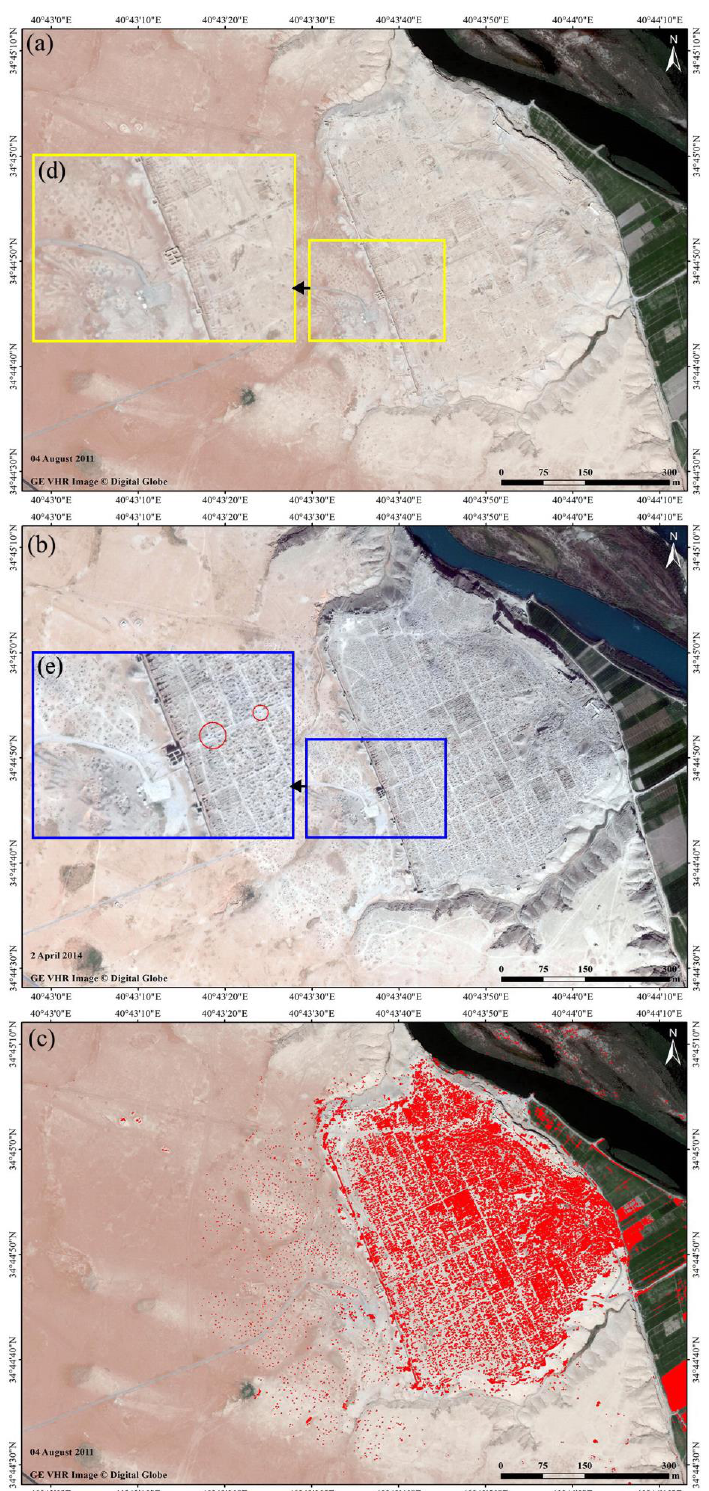
Figure 9. Dura Europos, eastern Syria, as it appears in images from August 2011 and April 2014. ( a ) Dozens of decades-old looting holes are visible in a close-up around the Palmyrene Gate; ( b ) The image from April 2014 shows a renewed phase of severe, war-related looting with fresh pits clearly visible in the same area; ( c ) The GE VHR image from 2011 was displayed with detected looting changes in red; ( d ) Close-up image from 2011; and ( e ) Close-up image from 2014. Imagery © 2018 Digital